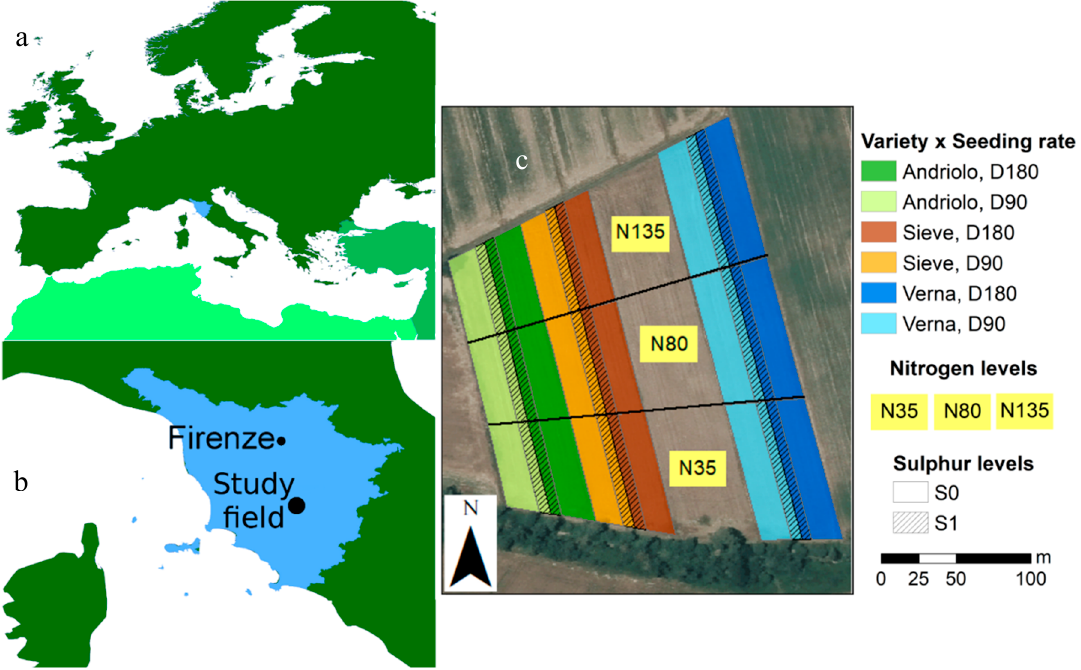
Figure 1. Maps of the study area. ( a ) Map of Tuscany within Europe. ( b ) Map of the Chianti region in Tuscany, and the location of the study field. ( c ) Layout of the study field. Seed densities levels D90 and D180 indicates 90 and 180 kg of seed ha − 1 , respectively. Nitrogen levels N35, N80 and N135 indicate 35, 80 and 135 kg N ha − 1 , respectively. Sulfur levels, S0 and S1 indicate 0 and 6.4 kg S ha − 1 , respectively. The area between the variety Sieve and Verna was cultivated with a ‘modern’ wheat variety ( Triticum aestivum , L var. Bologna) with the same cultivation techniques of the ‘old’ ones (Bologna variety results were not used in this paper).